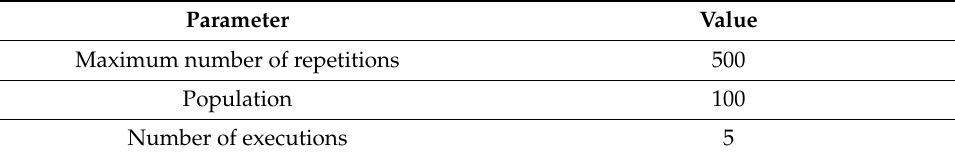
Table 4. Information on the